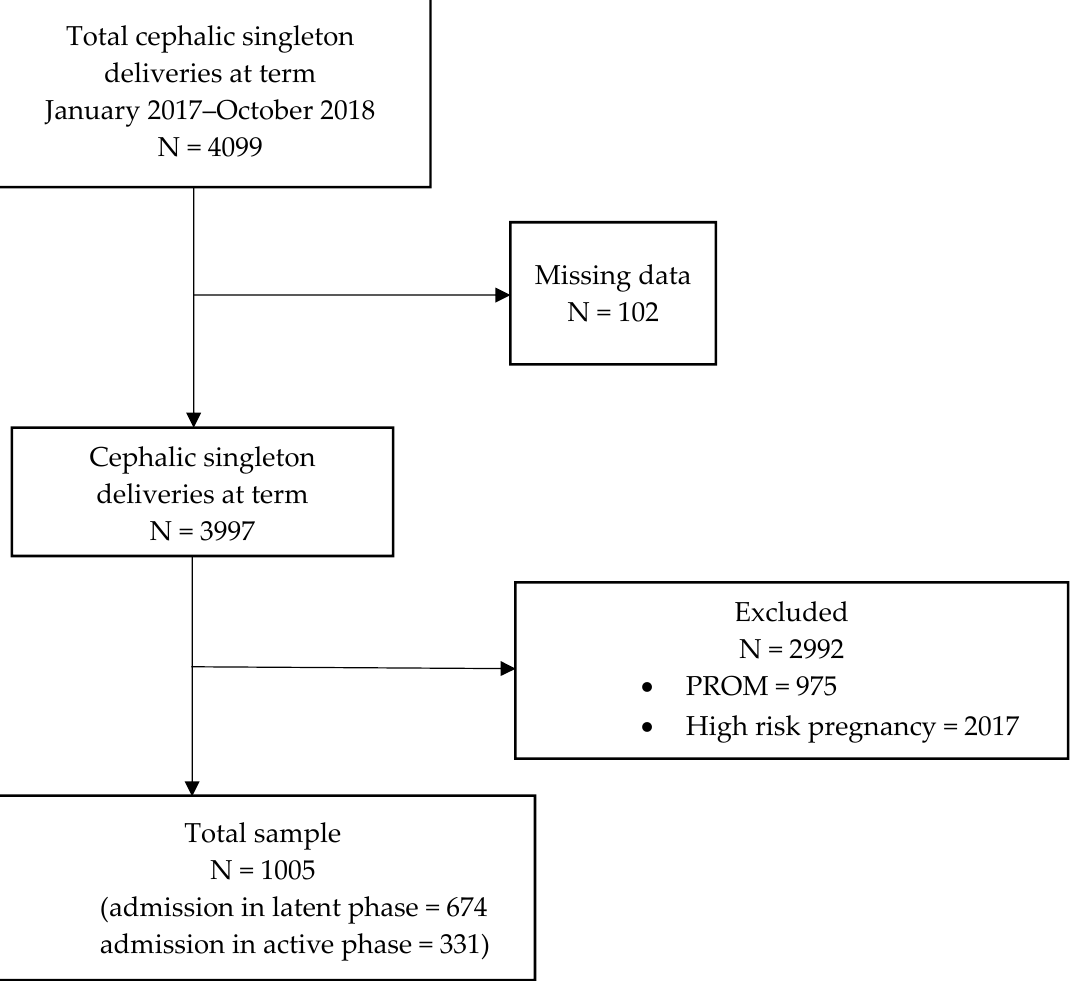
Figure 1. Patient enrollment flow chart. PROM: Premature rupture of